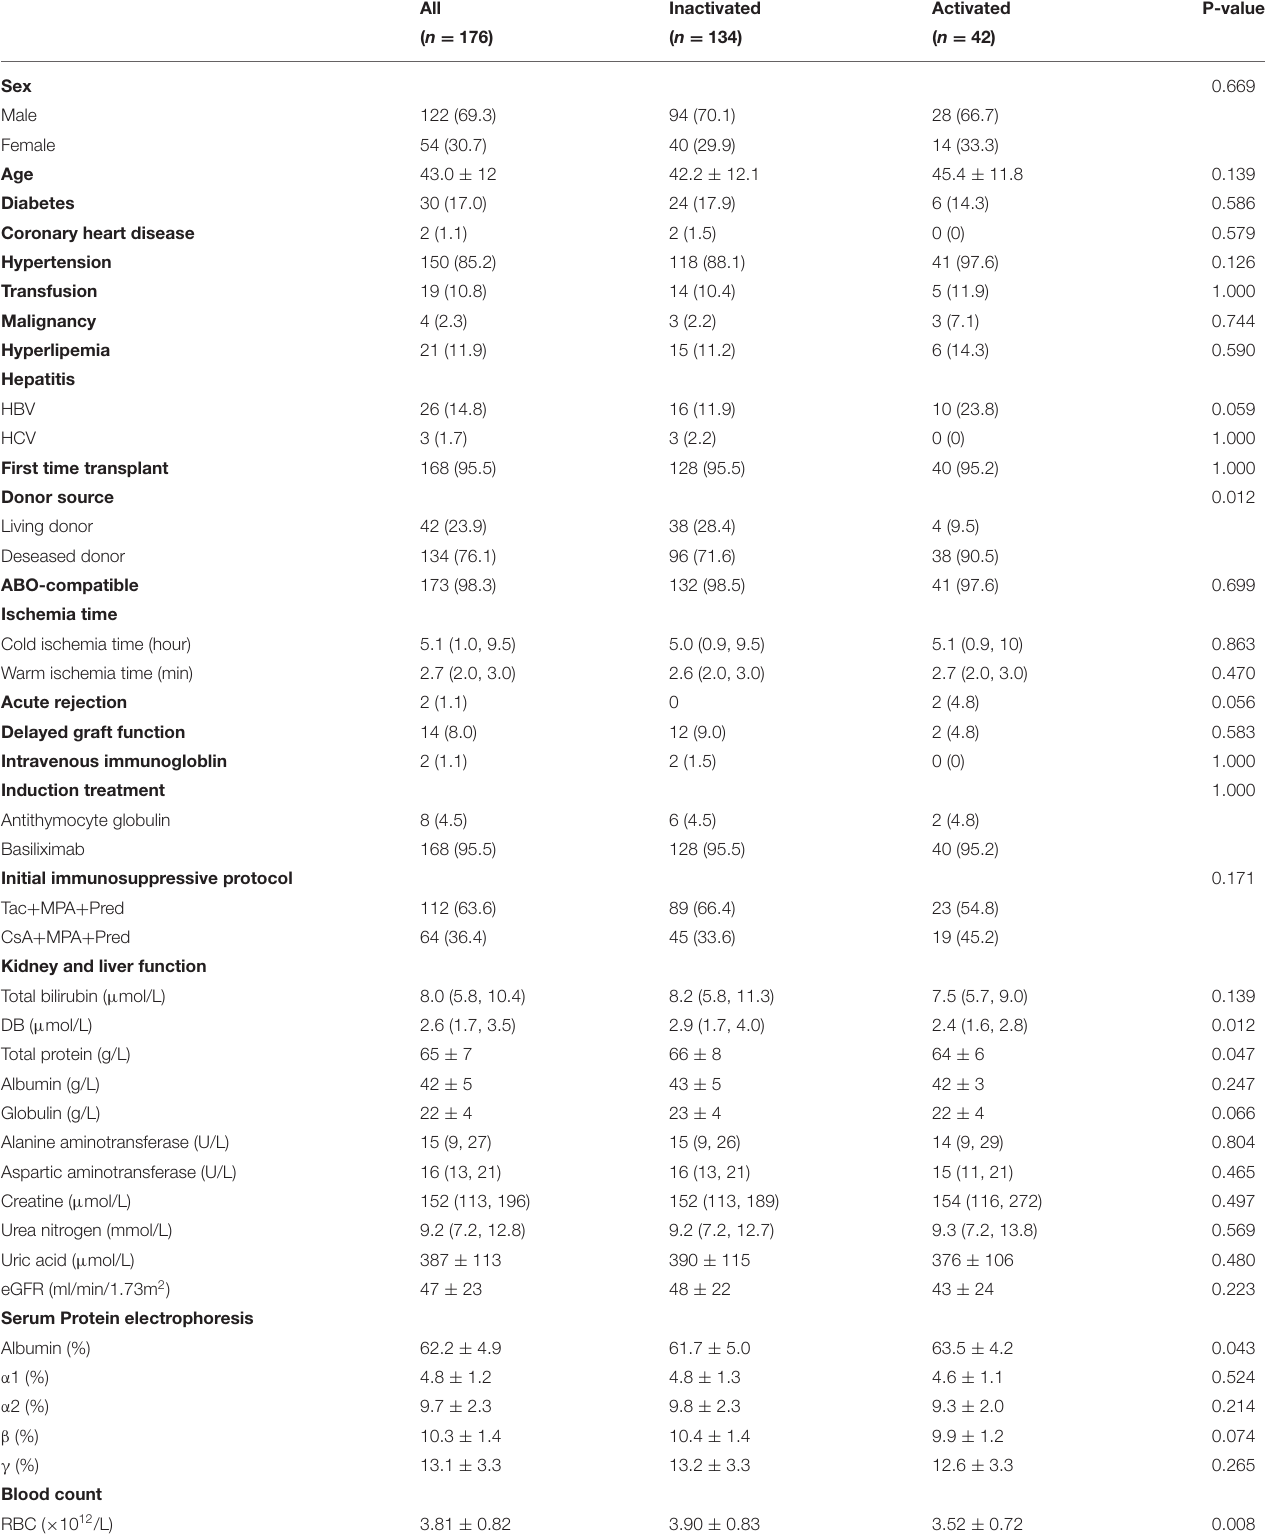
TABLE 1 | Baseline characteristics for patients with or without BKV active